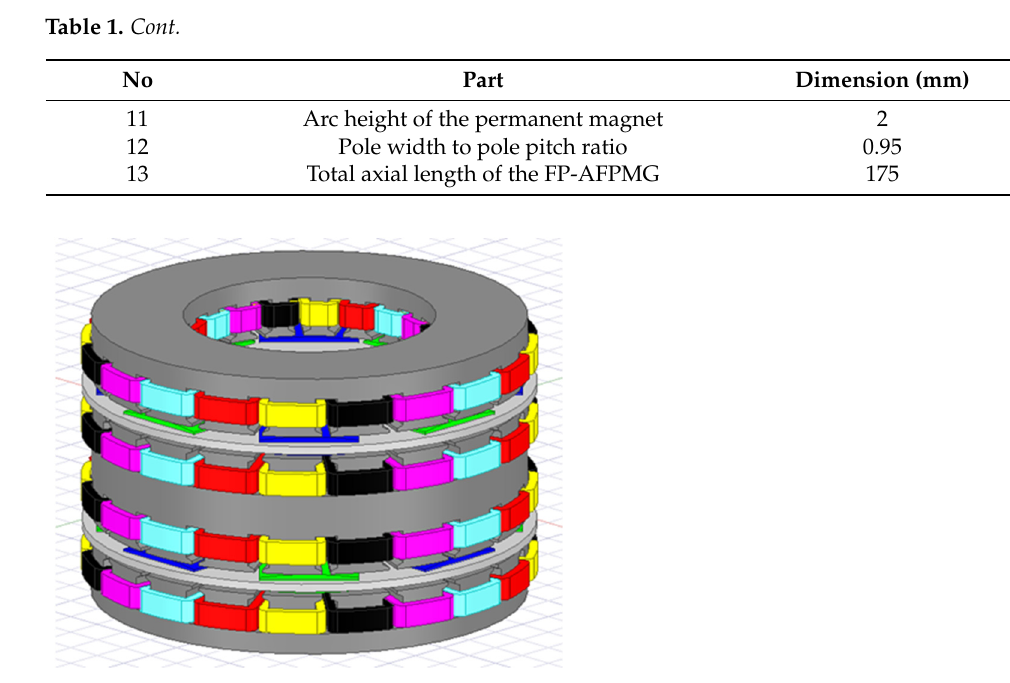
Figure 6. Modified shape of the axial flux permanent magnet generator in Figure